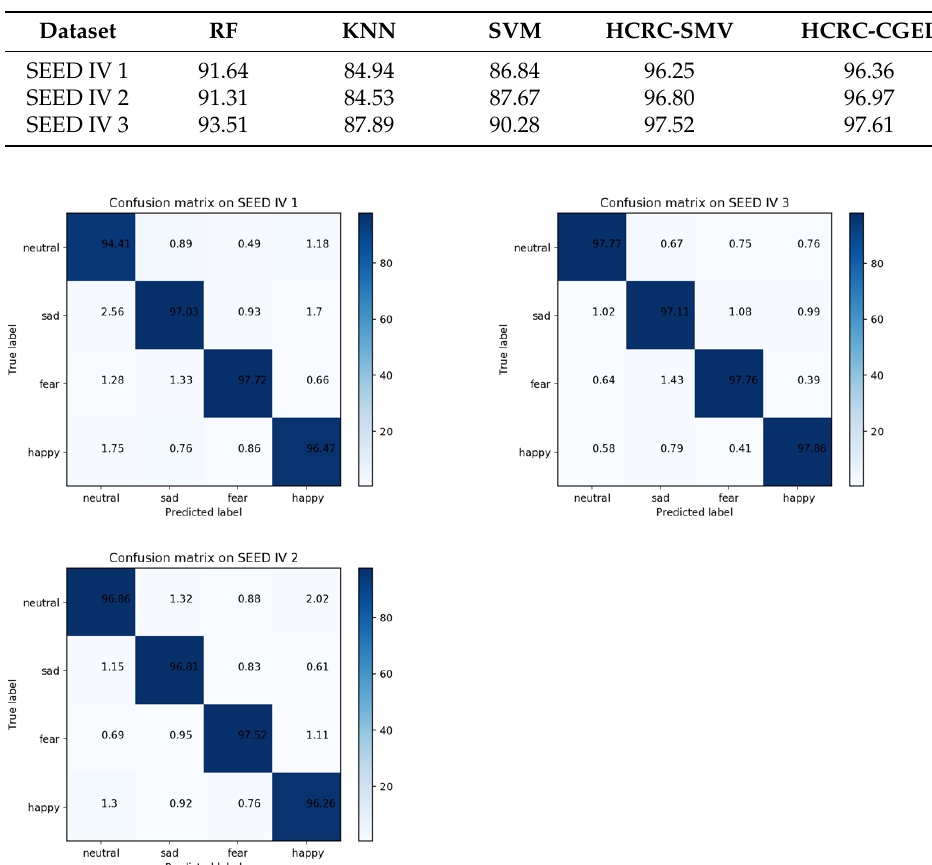
Figure 9. The confusion matrix in the three trials of SEED IV databases.